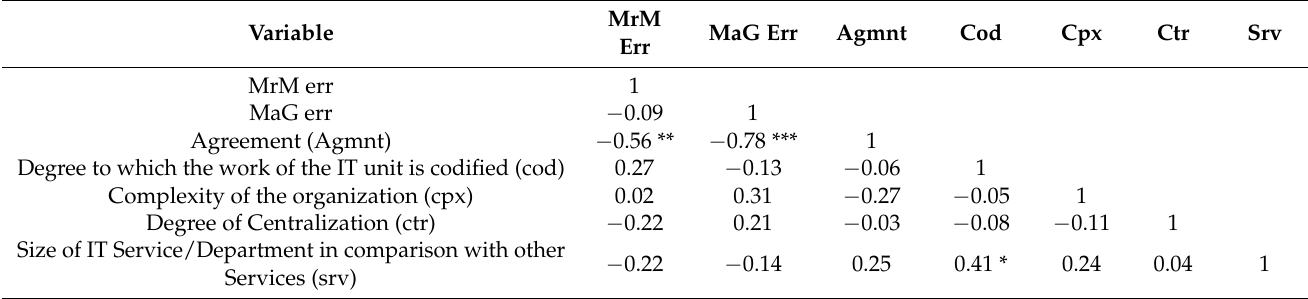
Table 6. Correlations among variables.